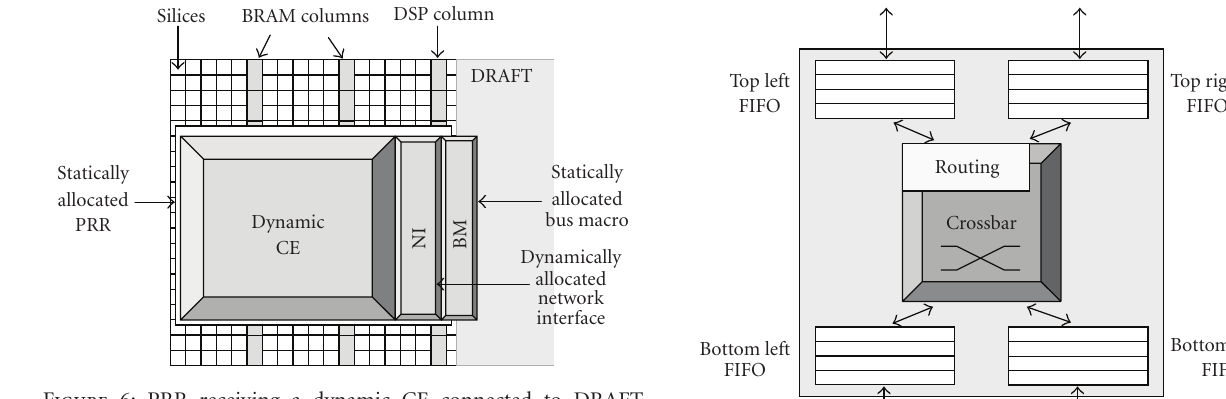
Figure 6: PRR receiving a dynamic CE connected to DRAFT through the dynamic NI and the static BMs.